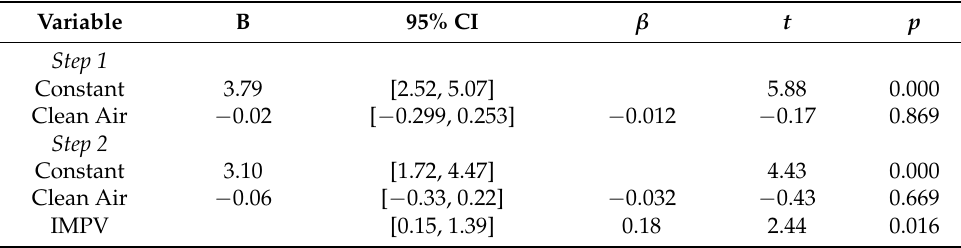
Table 3. Regression analysis summary for IPA and PHORS predicting trail